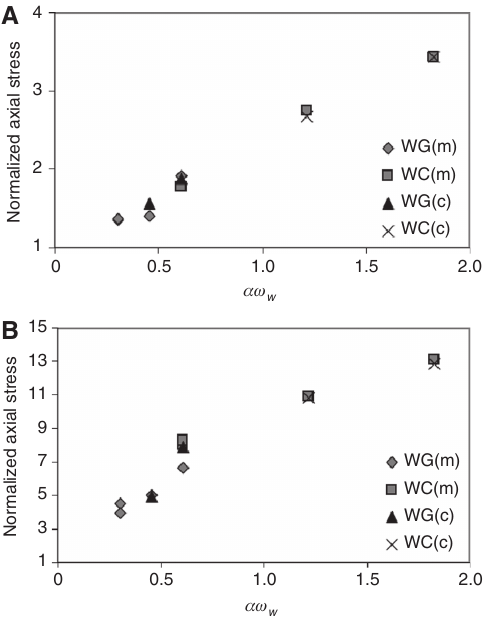
Figure 17 FRP-confined specimens: (A) normalized ultimate axial stress versus effective confinement index, (B) normalized ultimate axial strain versus effective confinement index (m, monotonic; c,